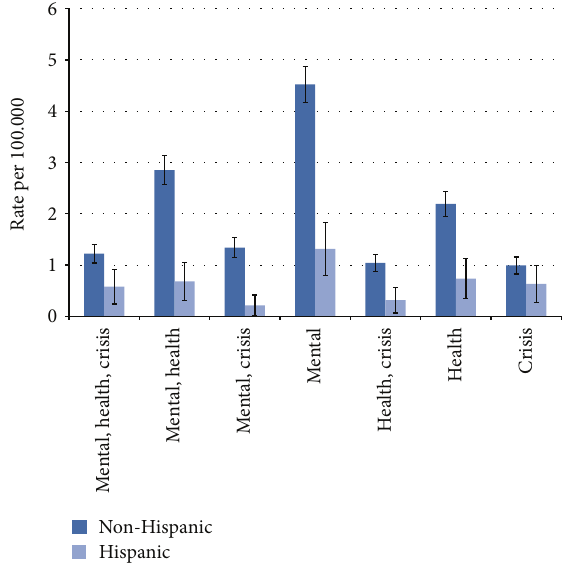
Figure 2: Selected combination of problems among non-Hispanic and Hispanic decedents in Utah, 2005–2010.